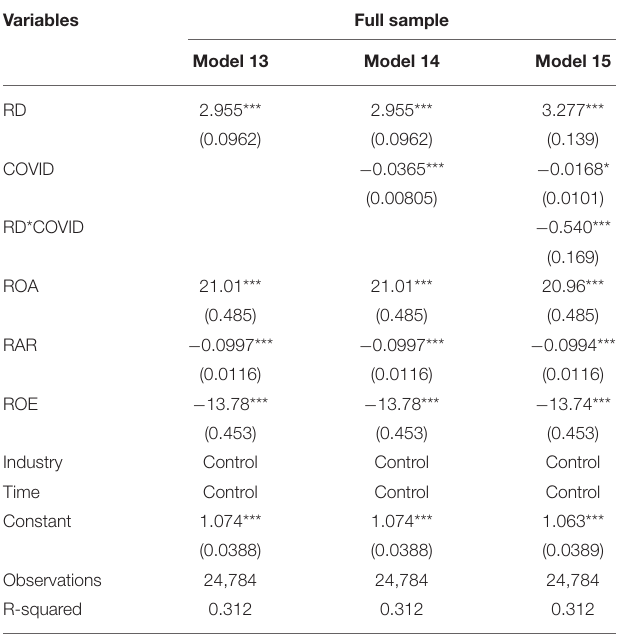
TABLE 5 | The impact of R&D investment on corporate financial risks under different risk